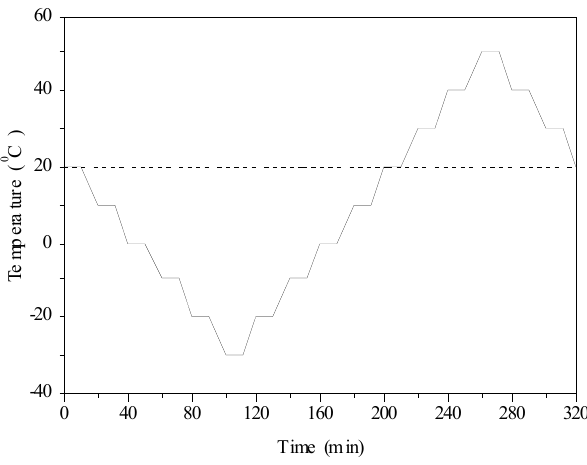
Figure 1. Temperature loading